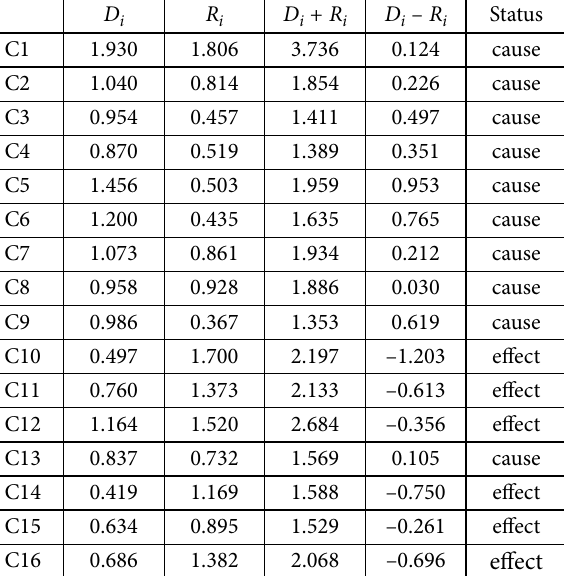
Figure 3. Steps of the proposed Table 1. Impacts on criteria